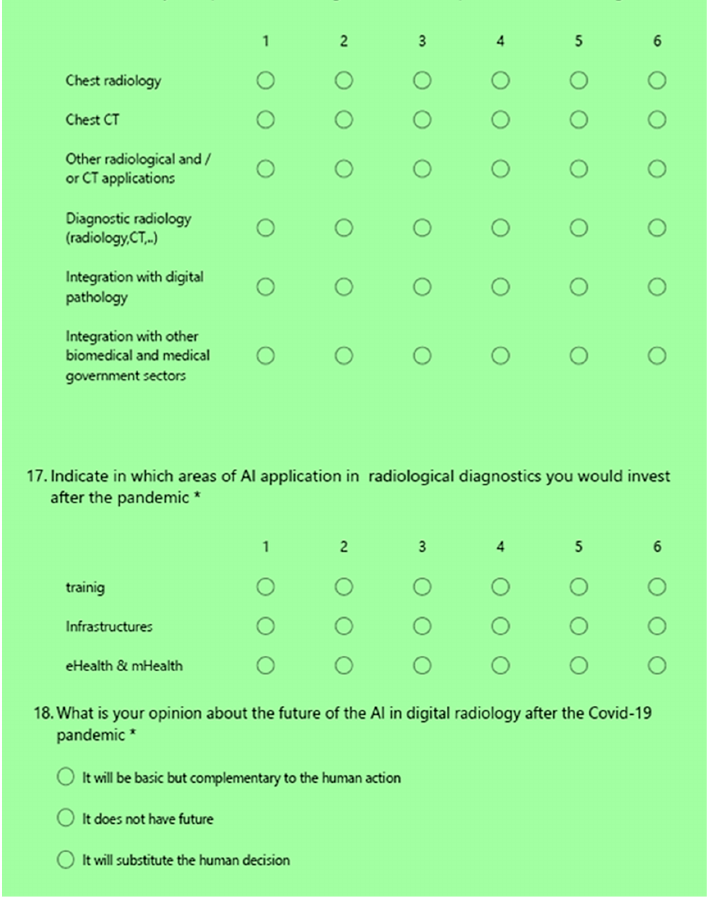
Figure 2. The questions focused on the perceived future of AI after the pandemic N. Q16, Q17, Q18.